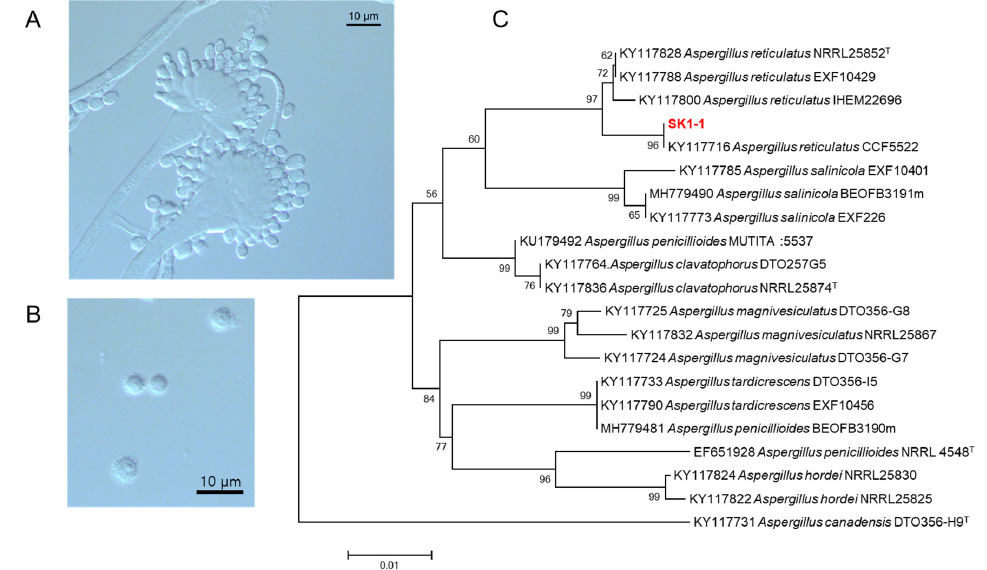
Figure 2. Morphological characterization and phylogenetic analysis of SK1-1. ( A , B ) Microscopic images of SK1-1 ( A ) conidiophores and ( B ) conidia. Scale bar = 10 µm. ( C ) Phylogenetic tree of SK1-1 obtained by a neighbor-joining analysis of β -tubulin sequences. Numbers at nodes indicate the percent bootstrap values from 1000 replicates (values < 50% are not shown). The scale bar indicates the number of nucleotide substitutions per site. “T” next to the strain name indicates the strain type of the species.